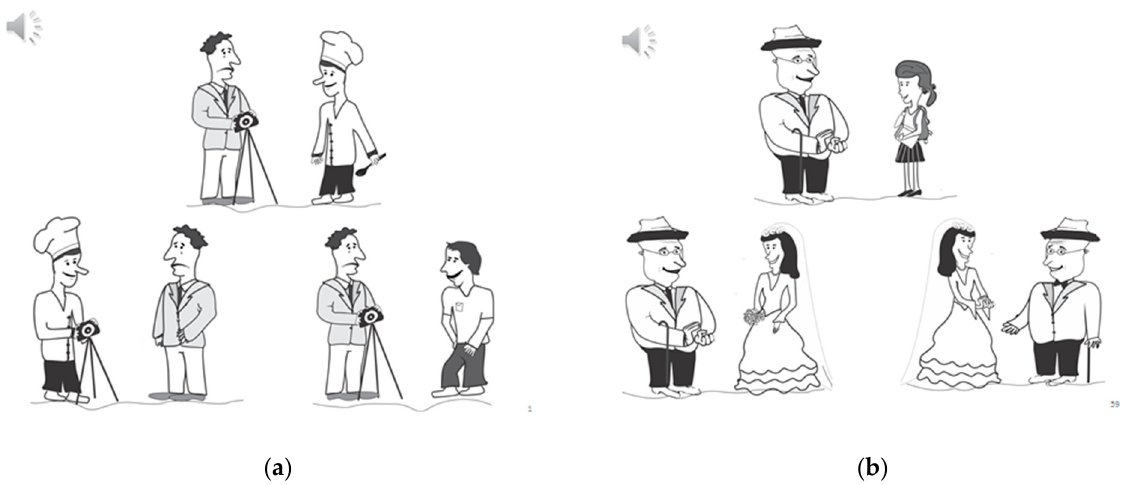
Figure 1. ( a ): SUBJ RC, gender match (8a), ( b ): SUBJ RC, gender mismatch